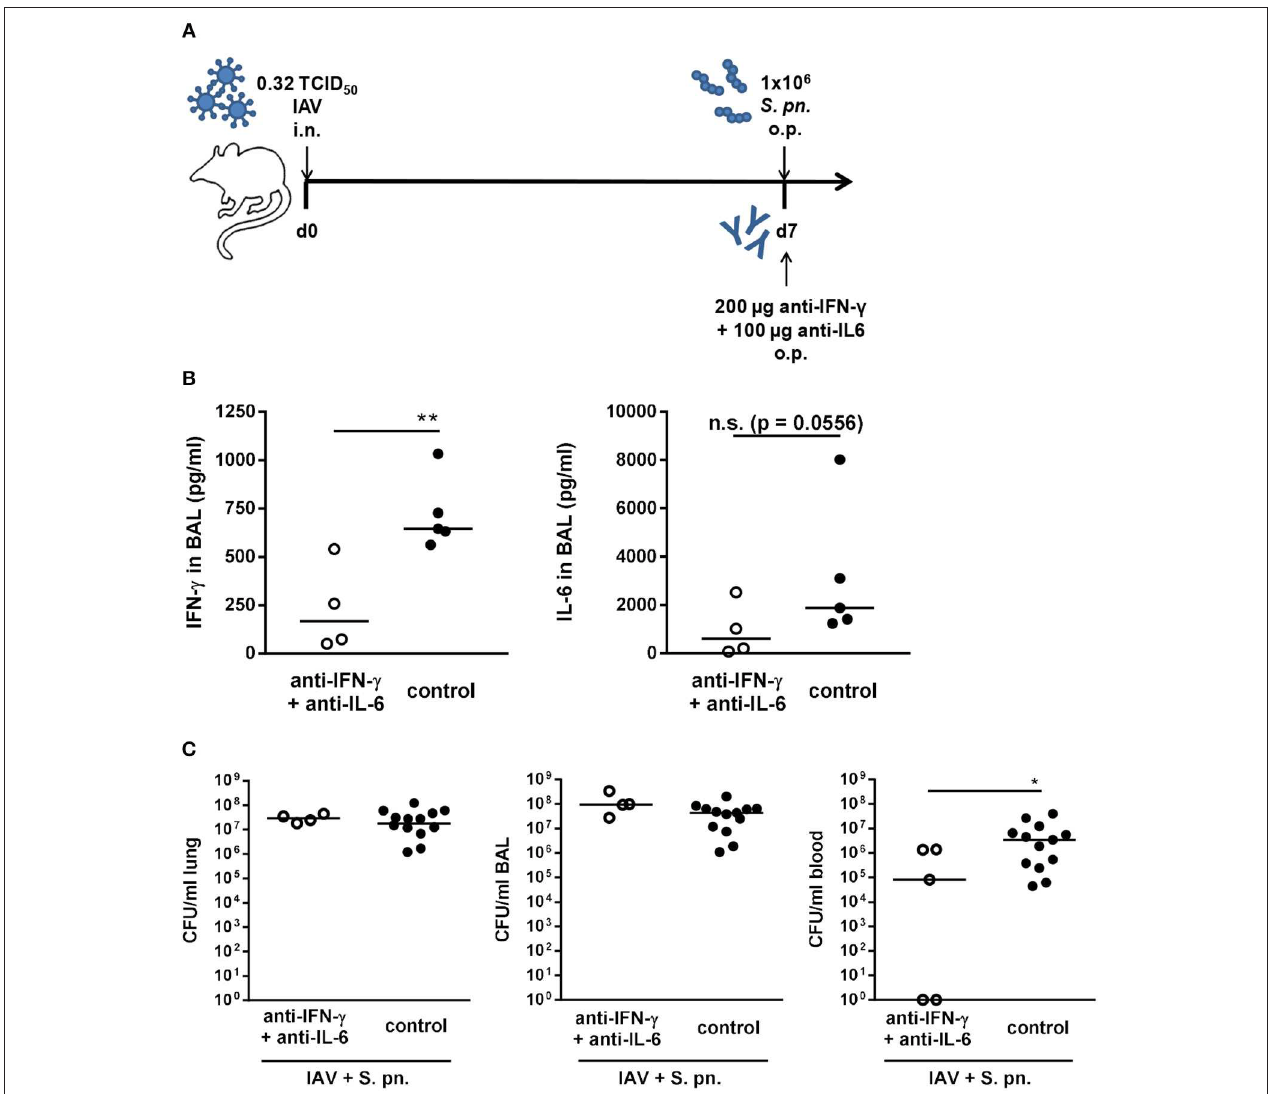
FIGURE 3 | Double-neutralization of IFN- γ and IL-6 during co-infection with 0.32 TCID 50 IAV and 1 × 10 6 CFU S. pn. Mice were infected intranasally (i.n.) with 0.32 TCID 50 IAV on day 0. On day 7, mice were treated with anti-IFN- γ antibody together with anti-Il-6 antibody and infected with 1 × 10 6 CFU S. pn . oropharyngeally (o.p.). The control group was infected likewise and treated with an isotype IgG antibody. (A) Experimental setup. (B) IFN- γ and Il-6 protein levels in bronchoalveolar lavage (BAL) 24h post antibody treatment and S. pn. infection. (C) S. pn. bacterial counts in lung tissue, BAL and blood 24h post antibody treatment and S. pn. infection. Data are shown for individual mice and lines indicate the median/group. Controls in (C) are compiled from independent experiments. Statistical analysis was performed using the unpaired, one-sided Mann-Whitney test [n.s., not significant ( p > 0.05), * p < 0.05, ** p < 0.01]. Data are compiled from at least two independent